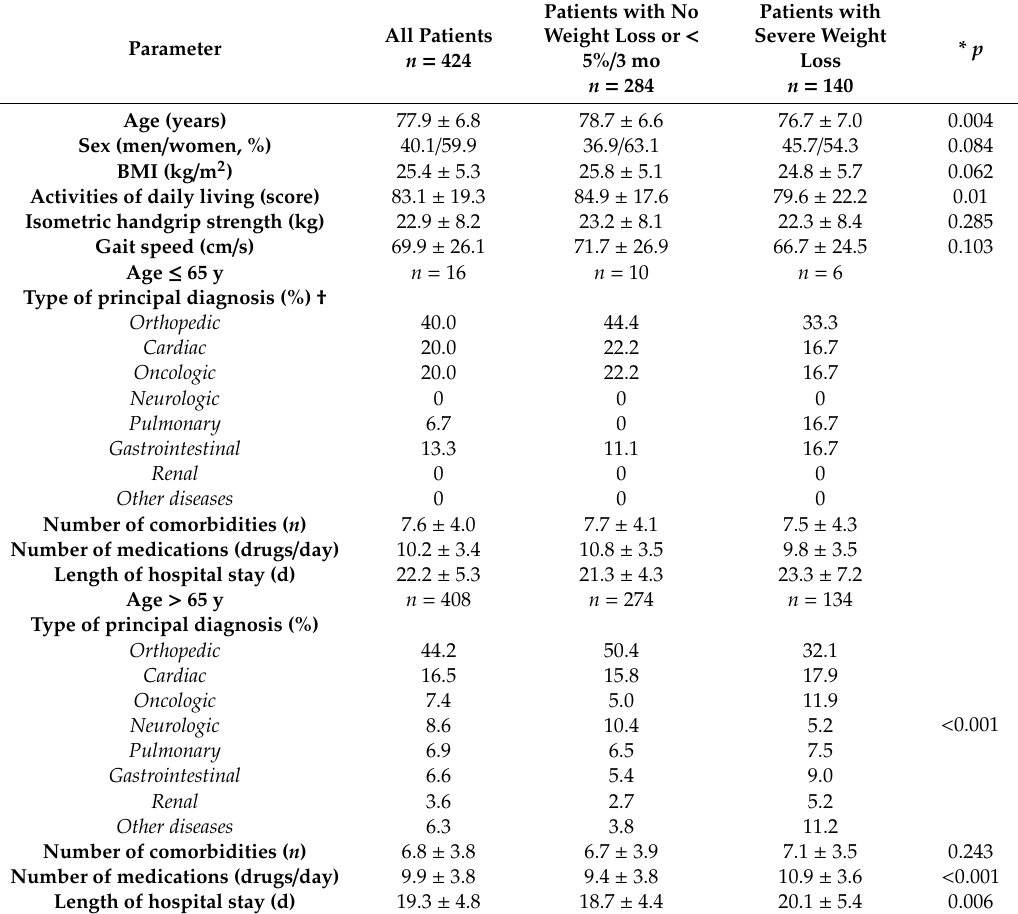
Table 1. Demographic, clinical characteristics, nutritional, and functional parameters of all recruited patients at hospital discharge and classified according to self-reported severe weight